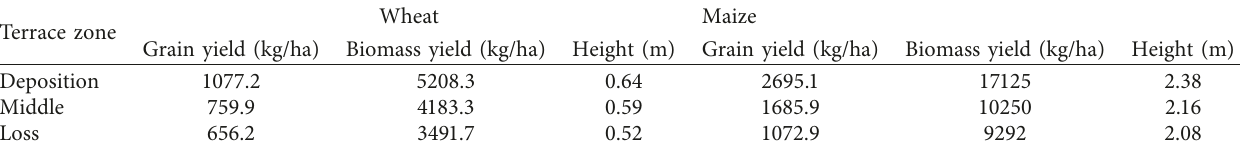
Table 3: Effect of terrace on the yield and yield components of crops